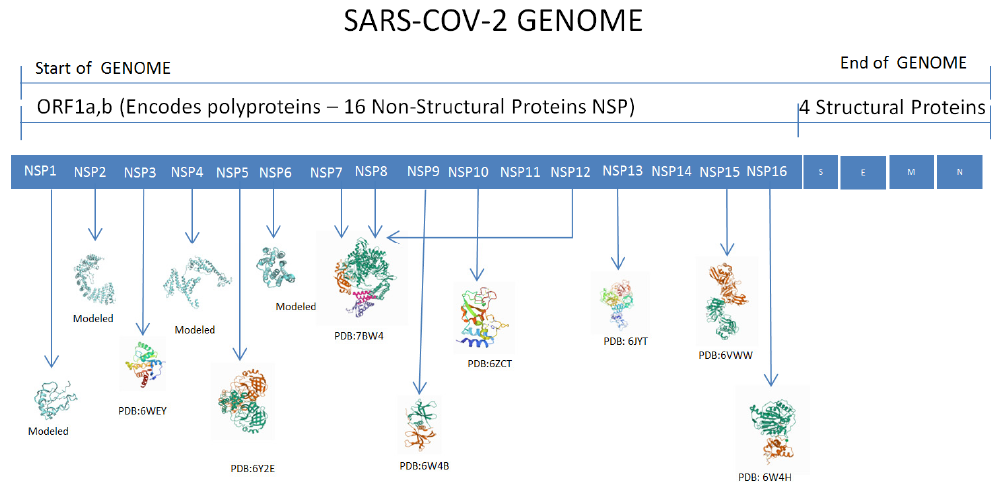
Figure 1. Cartoon representation of the SARS ‐ CoV ‐ 2 nonstructural proteins (nsps).